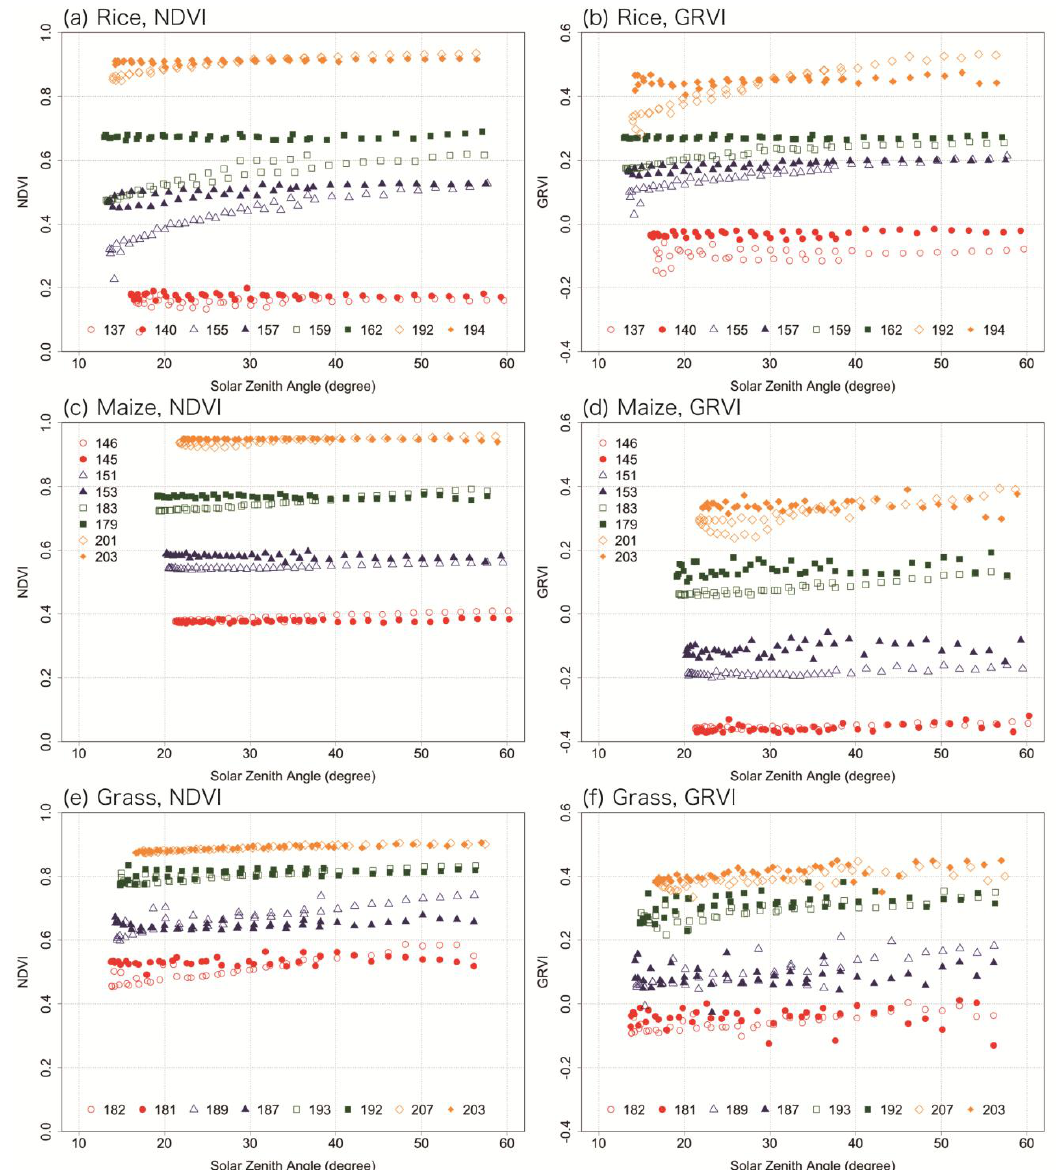
Figure 3. Relation between the NDVI ( left ), GRVI( right ), and the solar zenith angles on selected days during the growing season at the rice ( a , b ), maize ( c , d ) and grass ( e , f ) sites. Open symbols show the days under clear sky conditions and closed symbols show the days under cloudy sky